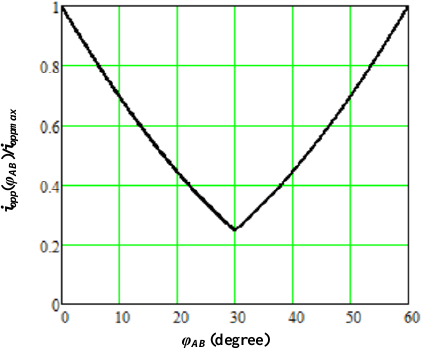
Figure 8. Current ripple comparison of lagging degree φ AB .